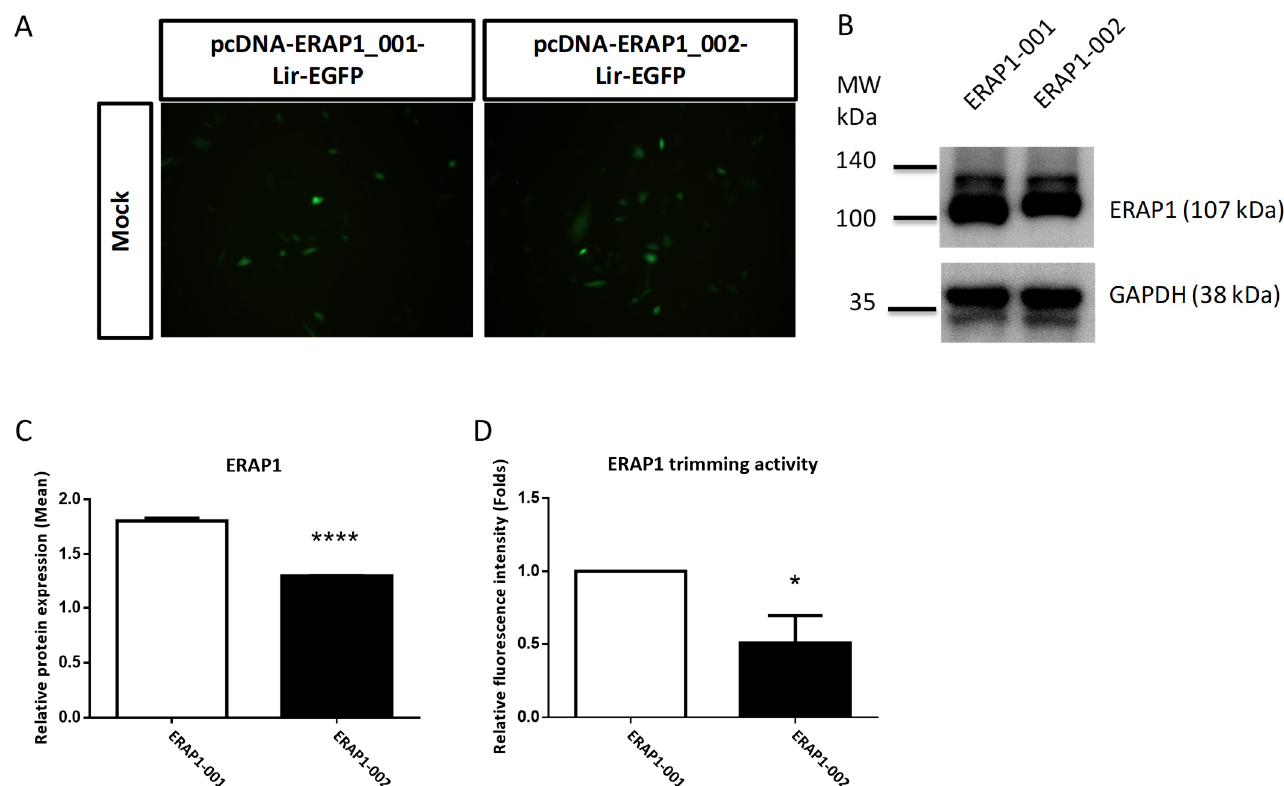
Figure 2. ERAP1 -001 exhibited considerably more ERAP1 protein expression and enzyme activity than ERAP1 -002 in transfected cells. ( A ) Representative images of CHO cells transfected with pcDNA-ERAP1-Lir-EGFP expression constructs. All pictures were taken with a FITC channel (Green) with a 450/490-nm filter set with the same exposure time (900 ms). ( B , C ) Western blot analysis of cellular lysates from transfected U937 cells with pcDNA-ERAP1-EGFP. Band intensities were quantified and shown as normalized to the loading control. ( D ) ERAP1 enzyme activity analysis. Enzymatic reactions were performed via a continuous florigenic assay. Data are one representative of three experiments. Data are shown as mean (SD). * p < 0.05; **** p < 0.0001.